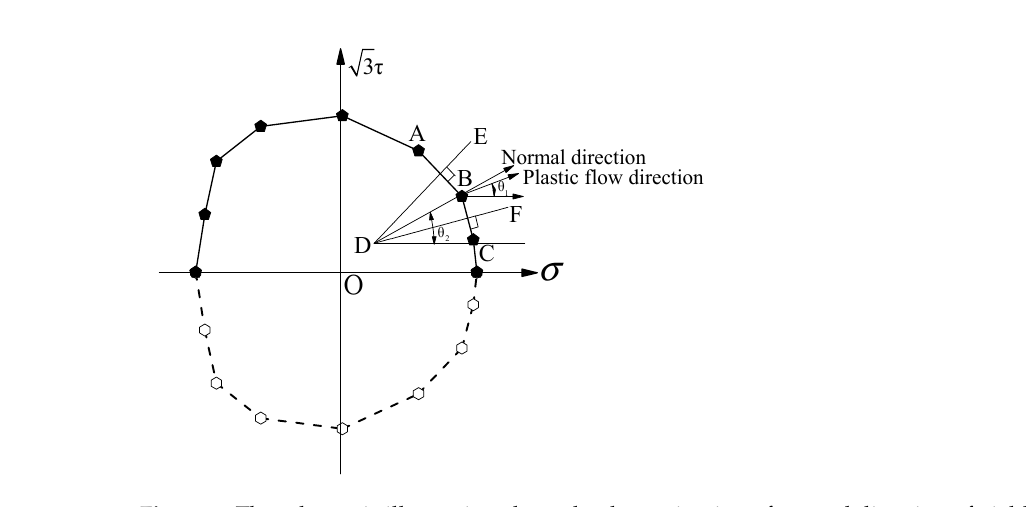
Figure 5. The schematic illustration about the determination of normal direction of yield point on yield surface and plastic strain incremental direction.